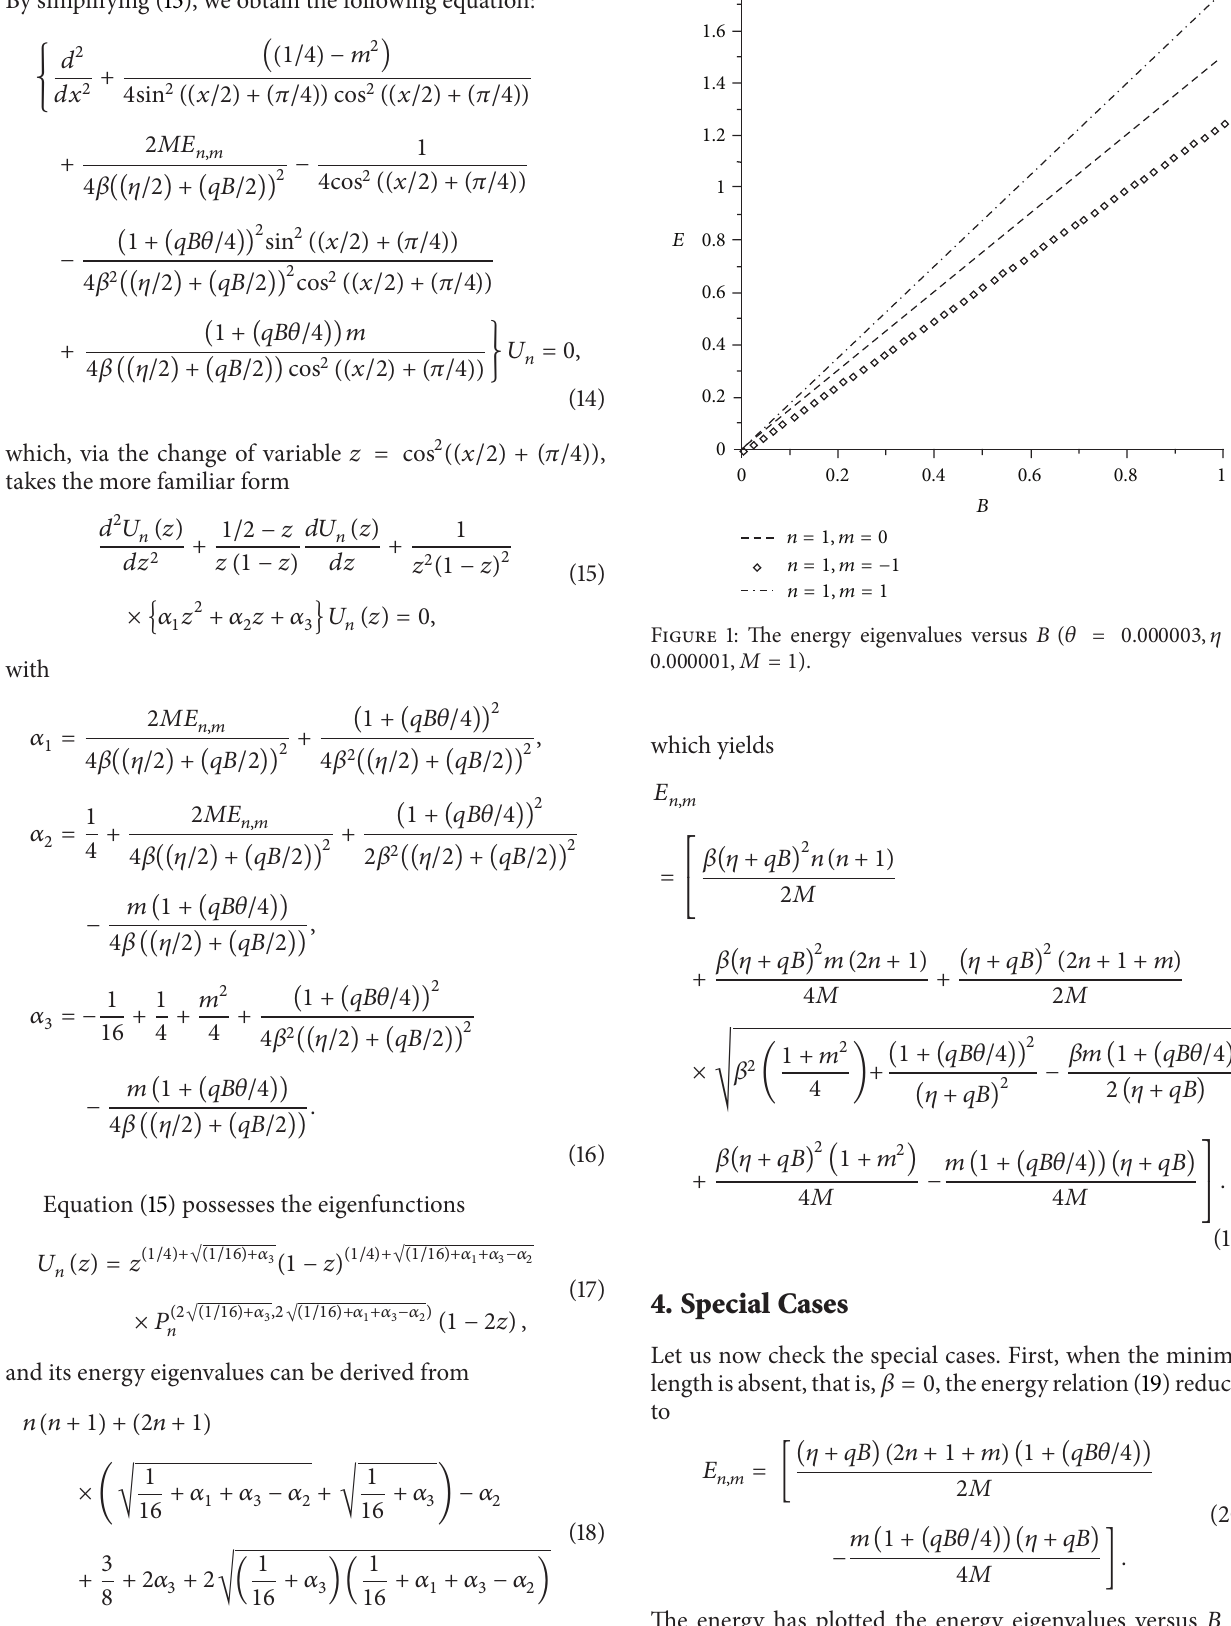
Figure 1. The energy relation in the special cases of 𝜃 = 0